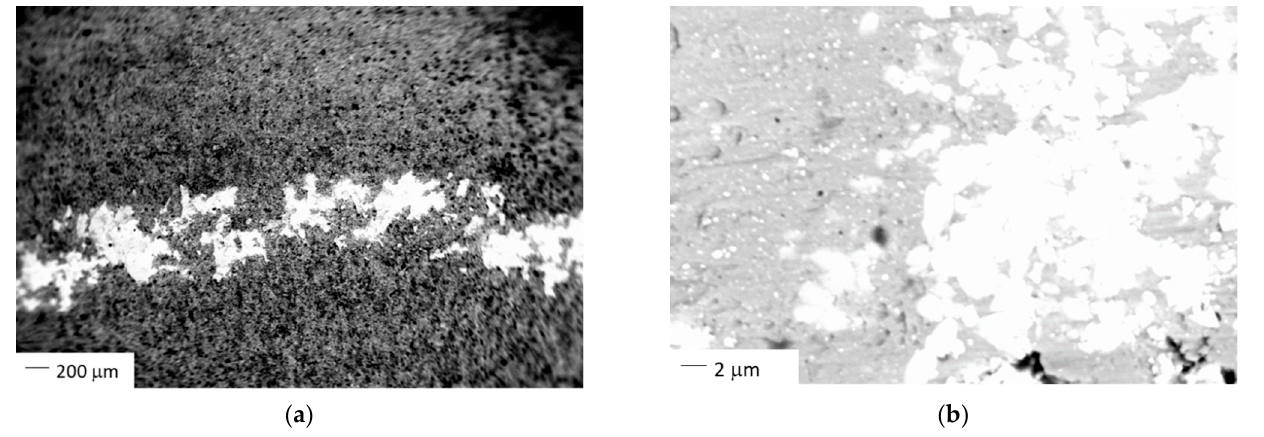
Figure 11. SEM micrograph ( a ) and a magnification ( b ) of wear tracks of WC-Ni.